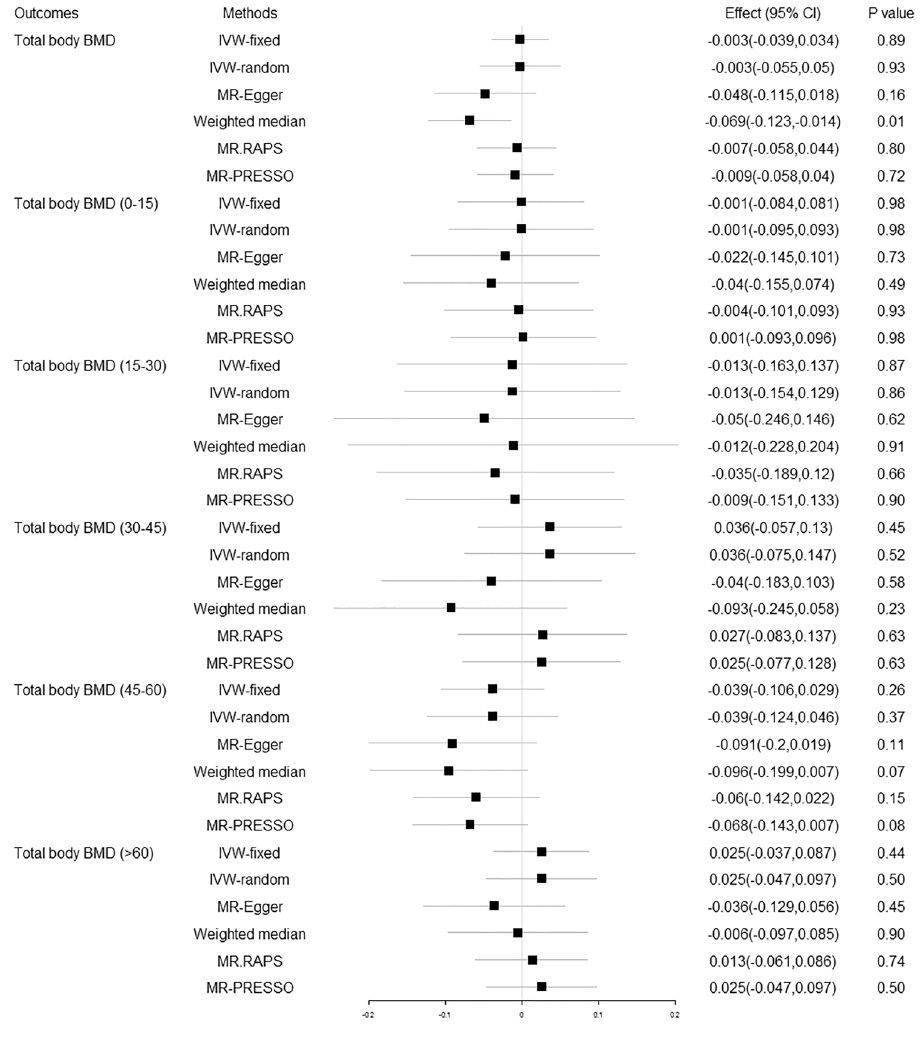
Figure 2. Causal effect of 25OHD on TB-BMD in different age groups. 25OHD 25-hydroxyvitamin D, BMD bone mineral density, Effect the combined causal effect of 25OHD on BMD, CI confidence interval, IVW-fixed inverse variance weighted with fixed effects, IVW-random inverse variance weighted with random effects, MR.RAPS MR Robust Adjusted Profile Score, MR-PRESSO MR Pleiotropy RESidual Sum and Outlier.